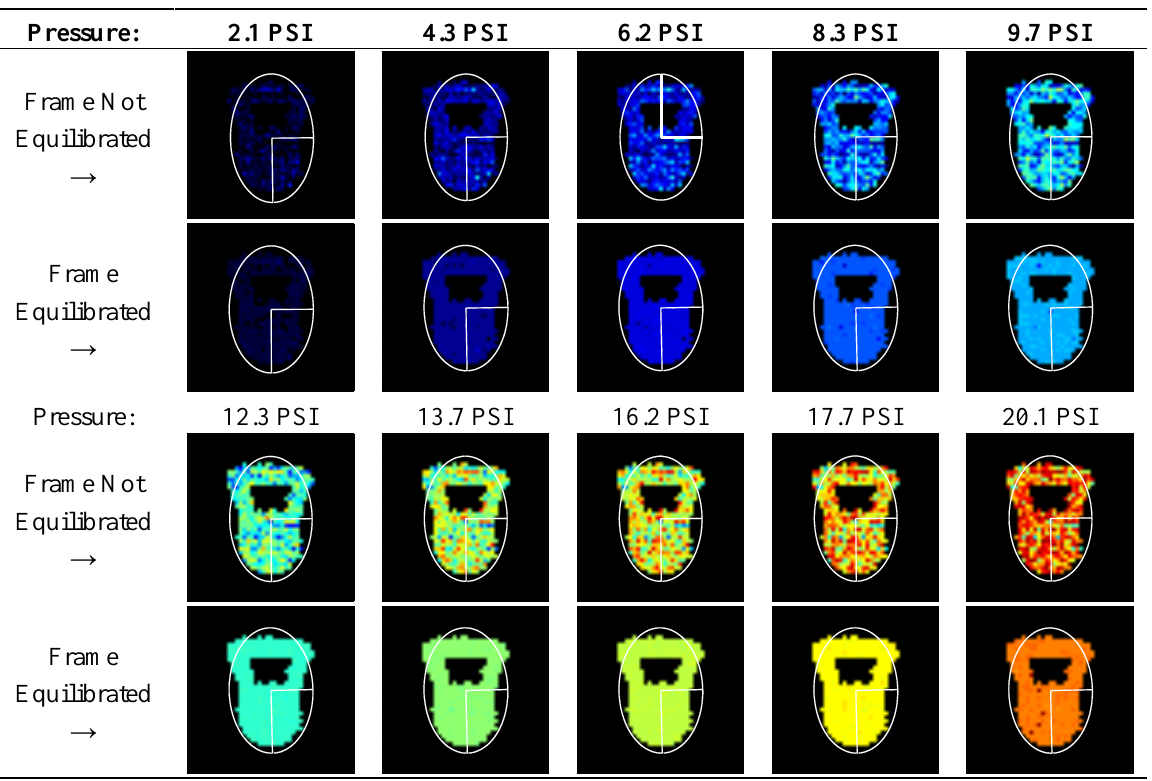
Table 8. Tactile images of the opener with and without